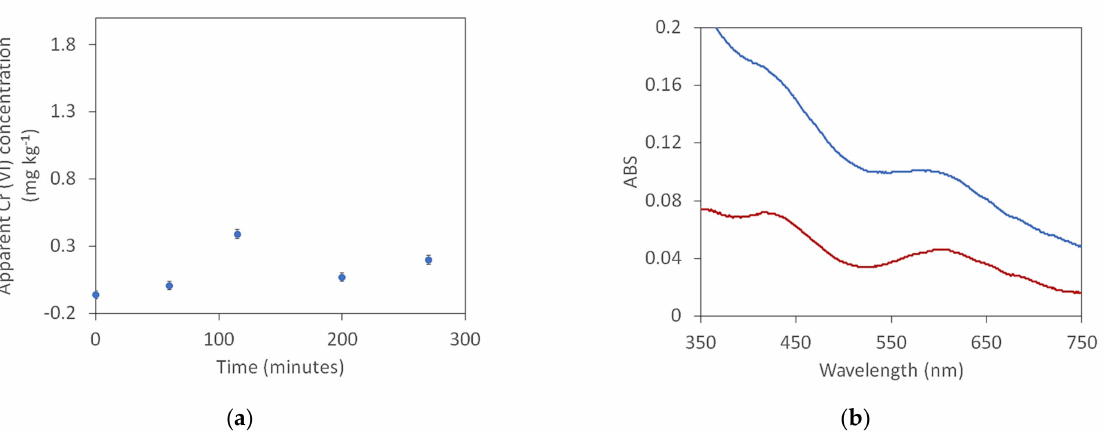
Figure 2. ( a ) Apparent Cr(VI) concentration (mg kg − 1 ) of a Cr(III) and gelatine solution vs. extrac- tion time (minutes), ( b ) UV spectra of the same solution after 115 min: with DPC (Blue), without DPC